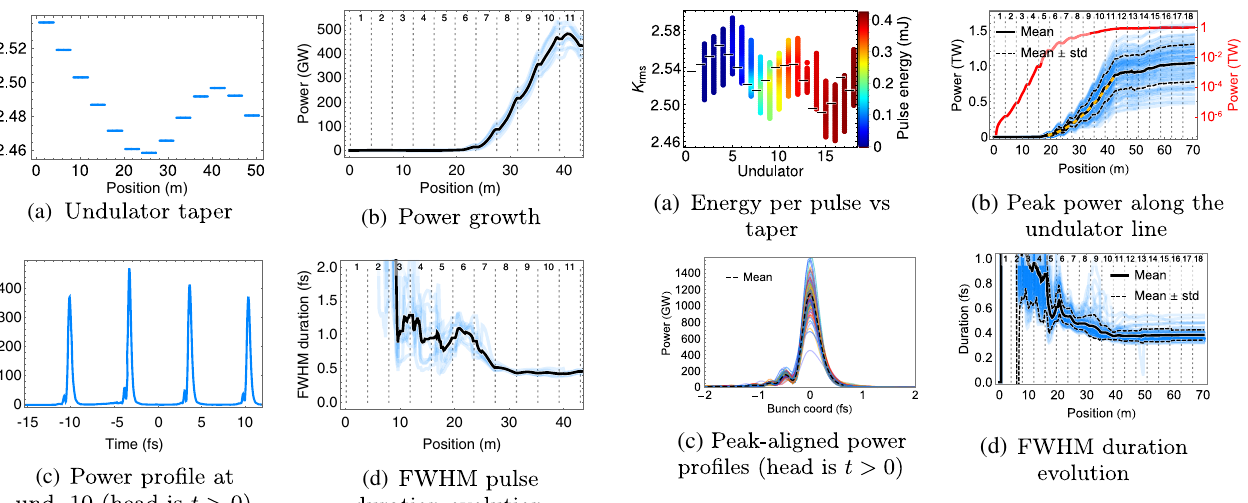
FIG. 3. Optimal detuning chirp-taper simulations. (a) shows how undulators are varied sequentially to maximize the x-ray pulse power and energy at the output of each undulator segment (colored points) along the undulator line for an average of three shots with different random seeds. The remaining plots show the results of 100 simulations for the optimized taper shown as black line segments in (a). The dashed yellow line in (b) shows a power- law function fit to the mean power in undulators 5 – 11 with an exponent of 1.97 in agreement with superradiance, and the red line shows the log-scaled power to highlight the exponential gain in the first five undulators. (c) shows pulse profiles for the third of four pulses in the pulse